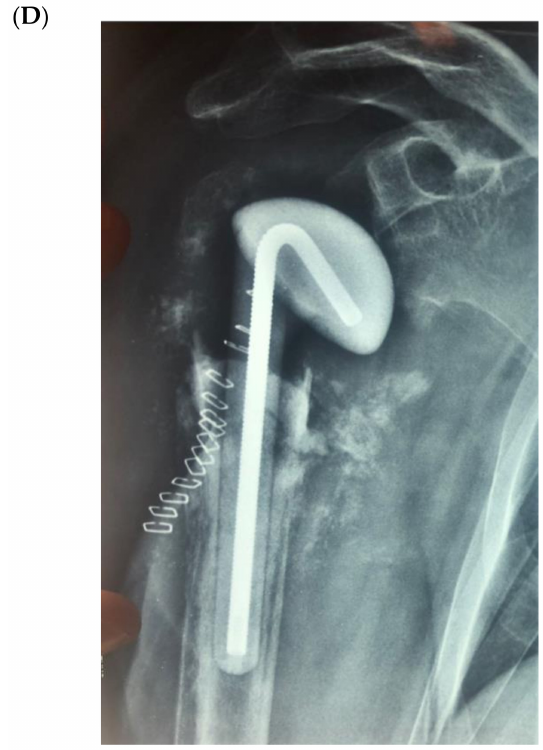
Figure 4. ( A ) The X-ray of a case of an infected proximal humerus fracture sequelae, originally treated with a plate. ( B ) After plate removal, the first RSA was implanted, which subsequently dislocated, resulting in infection. ( C ) A two-stage procedure was performed: removal of the RSA, debridement and implant of a cement antibiotic spacer with vancomycin. ( D ) Spacer X-ray postoperative